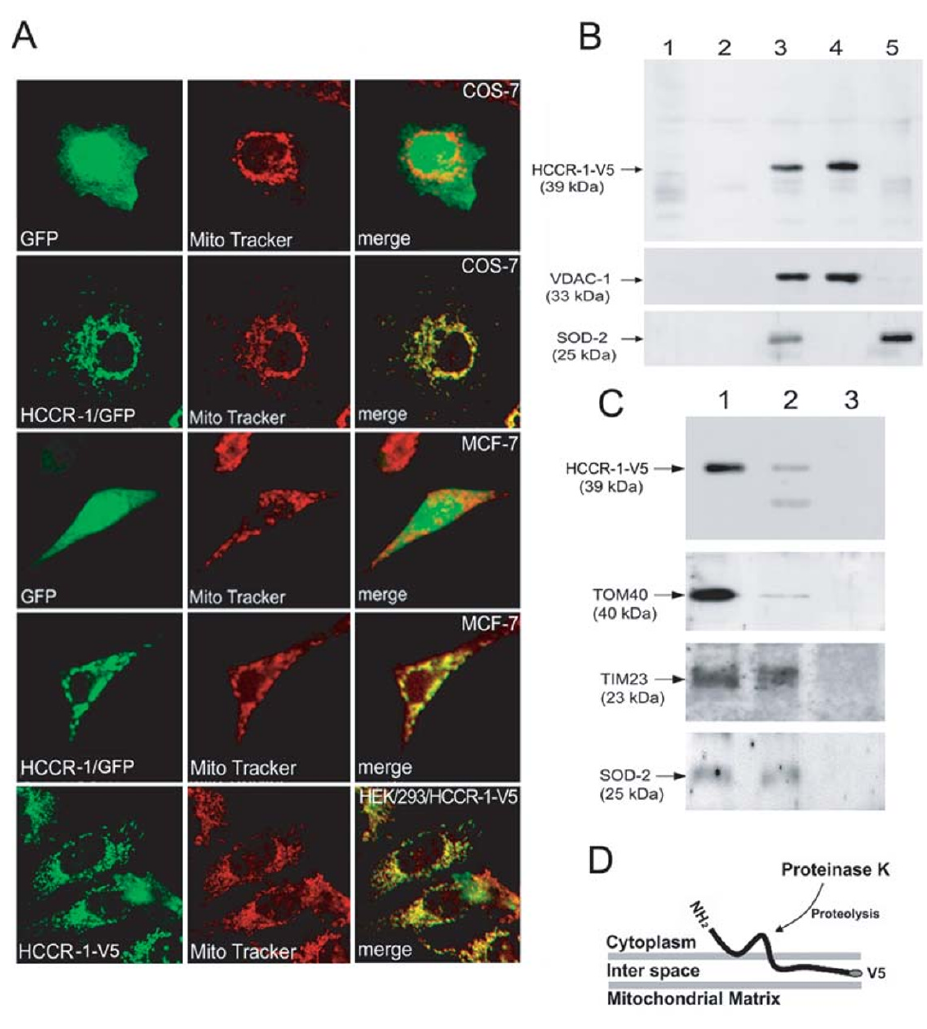
Figure 2 HCCR-1 is localized on the mitochondria outer membrane . (A) COS-7 (top and second panels), MCF-7 (third and forth panels) and HEK293/HCCR-1-V5 (bottom panel) cells were cultured on the pre-coated coverslip for overnight. COS-7 and MCF-7 cells were transiently transfected with the pEGFP-N1 vector (GFP) or the vector carrying the human HCCR-1 gene tagged with GFP at its COOH-terminus (HCCR-1/GFP). The cells were incubated with MitoTracker (Red), fixed with 4% paraformaldyhyde. HEK293/HCCR-1-V5 cells were stained with MitoTracker (Red) and fixed with 100% methanol for 1 min at -20°C. Mouse anti-V5 antibody (1:300 dilution) and goat anti-mouse IgG conjugated with HRP (5 μ g/ml) were applied to the cells for 1 h at room temperature (HCCR-1-V5). The cells were mounted and examined using a confocal microscope. (B) HCCR-1 is expressed at the mitochondrial membrane in the HEK293 cell line. Subcellular fraction of HEK293/HCCR-1-V5 cell line. HEK293/HCCR-1-V5 cells were fractionated into the nuclei (lane 1), post-mitochondria (lane 2), and mitochondria (lane3) CO and fractionated by centrifuga- fractions by differential centrifugation. Isolated mitochondria were treated with 0.1 M Na 2 3 tion at 100,000 g into pellets (lane 4) and supernatant (lane 5). Proteins were analyzed by immunoblotting using antibodies to the V5 epitope (top panel), the mitochondrial membrane protein VDAC-1 (middle panel) and the mitochondrial matrix protein SOD-2 (bottom panel). (C) HCCR-1 topology on the mitochondrial outer membrane. Intact mitochondria were incubated for 30 min at room temperature without (lane 1) and with 50 μ g/ml proteinase K (lane 2) or with 50 μ g/ml proteinase K plus 1% Triton X-100 (lane 3). Each sample was precipitated with TCA and separated by SDS-PAGE and analyzed by immunoblotting with antibodies to V5 (top panel), to the outer membrane protein TOM40 (second panel) and to the inner membrane protein TIM23 (third panel), and to the matrix protein SOD-2 (bottom panel). (D) Schematic diagram shows the HCCR-1 topology at the outer mitochondrial